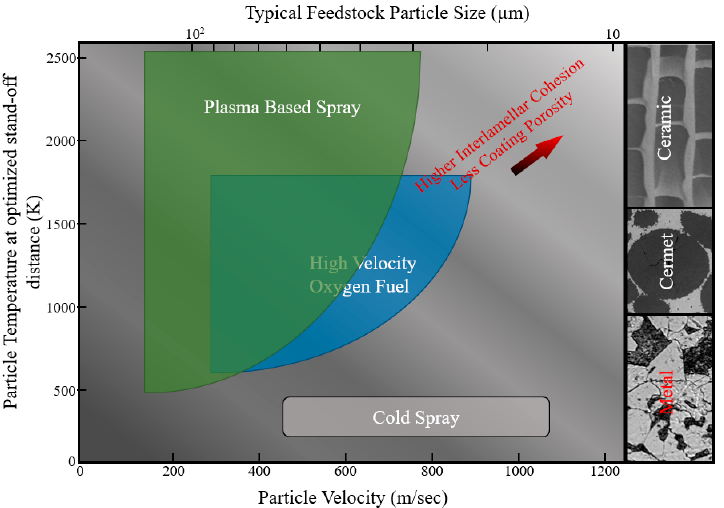
Figure 2. Classification of thermal spray coating methods based on processing parameters such as particle velocity, feedstock particle size distribution, and particle temperature at optimized stand- off distance.